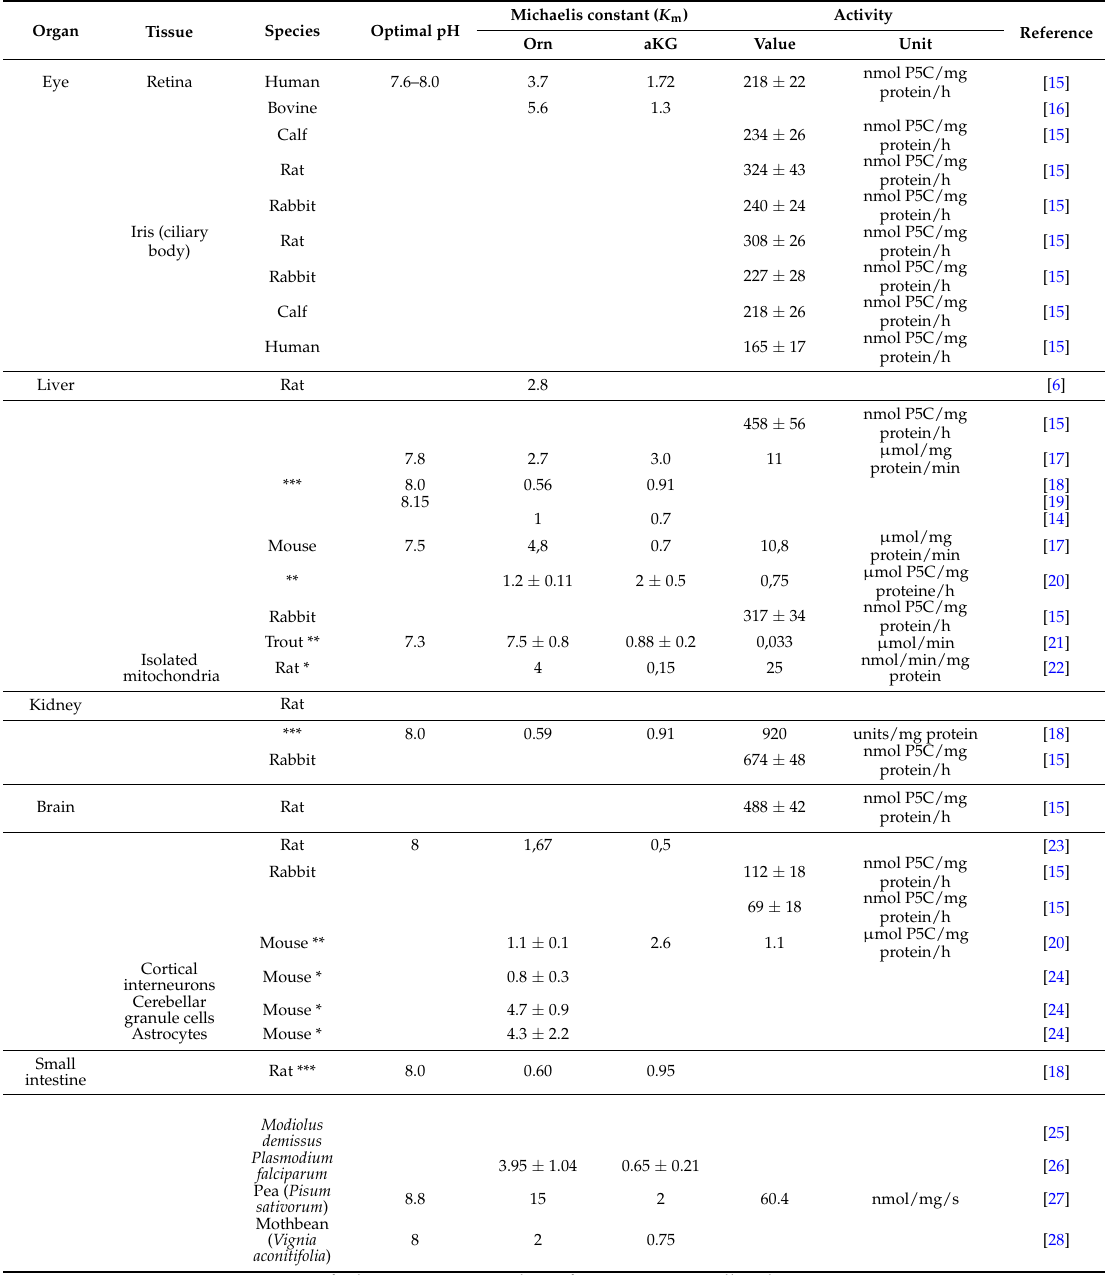
Table 1. Summary of the kinetic properties of OAT according to the tissue and the organism. Values of the Michaelis constant, K m , are given in